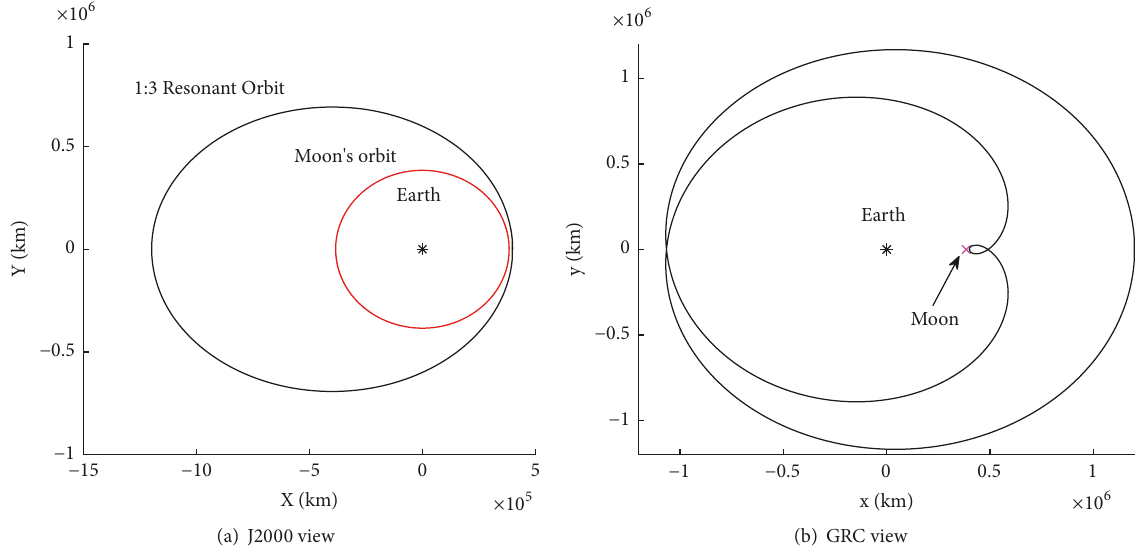
Figure 2: J2000 and GRC views of a spacecraft in a 1:3 resonant orbit with the Moon.